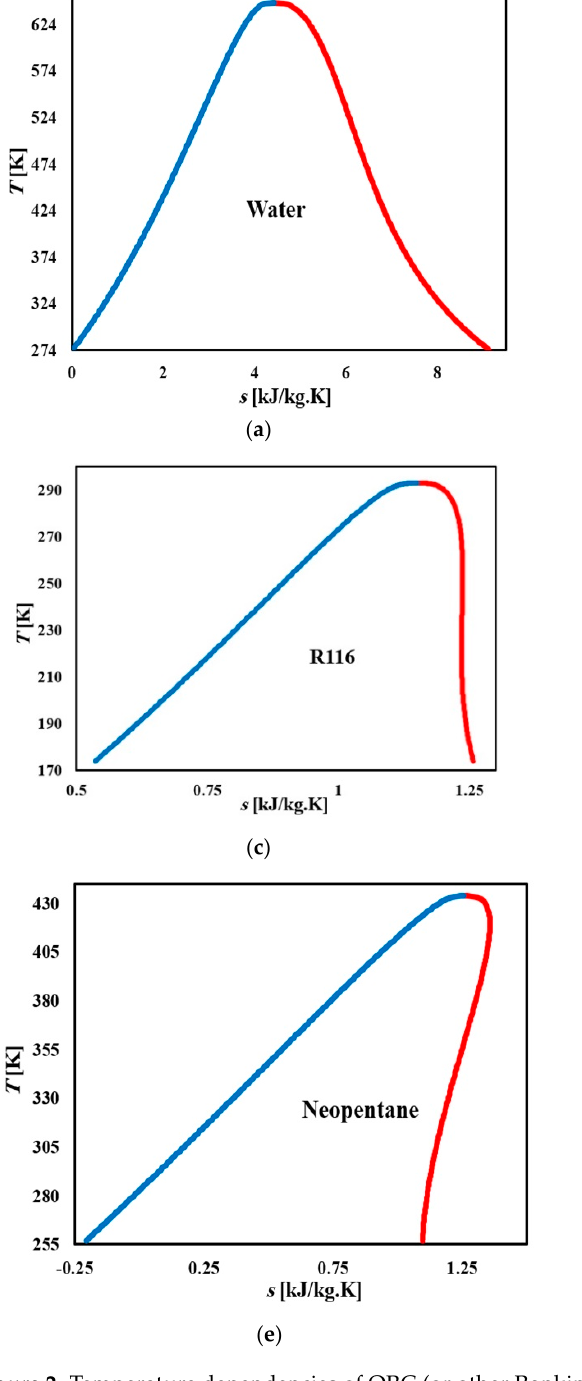
( b ) Figure 3. Steps of the efficiency-calculation for ORC ( a ) and TFC ( b ) cycles. Concerning efficiency, the actual values were calculated by using the following equa- tion: